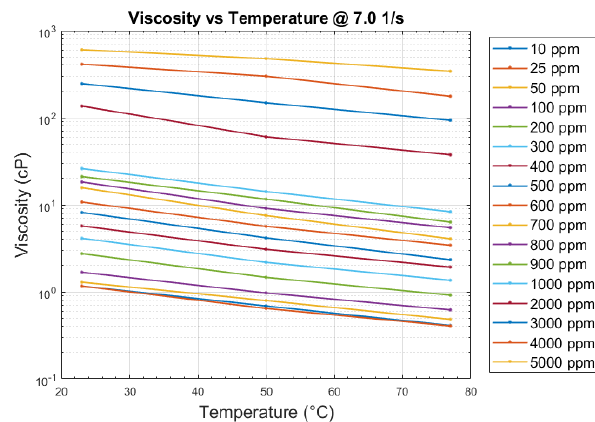
Figure 13: Viscosity versus Temperature at 7.0 1/s and 20,000 ppm of